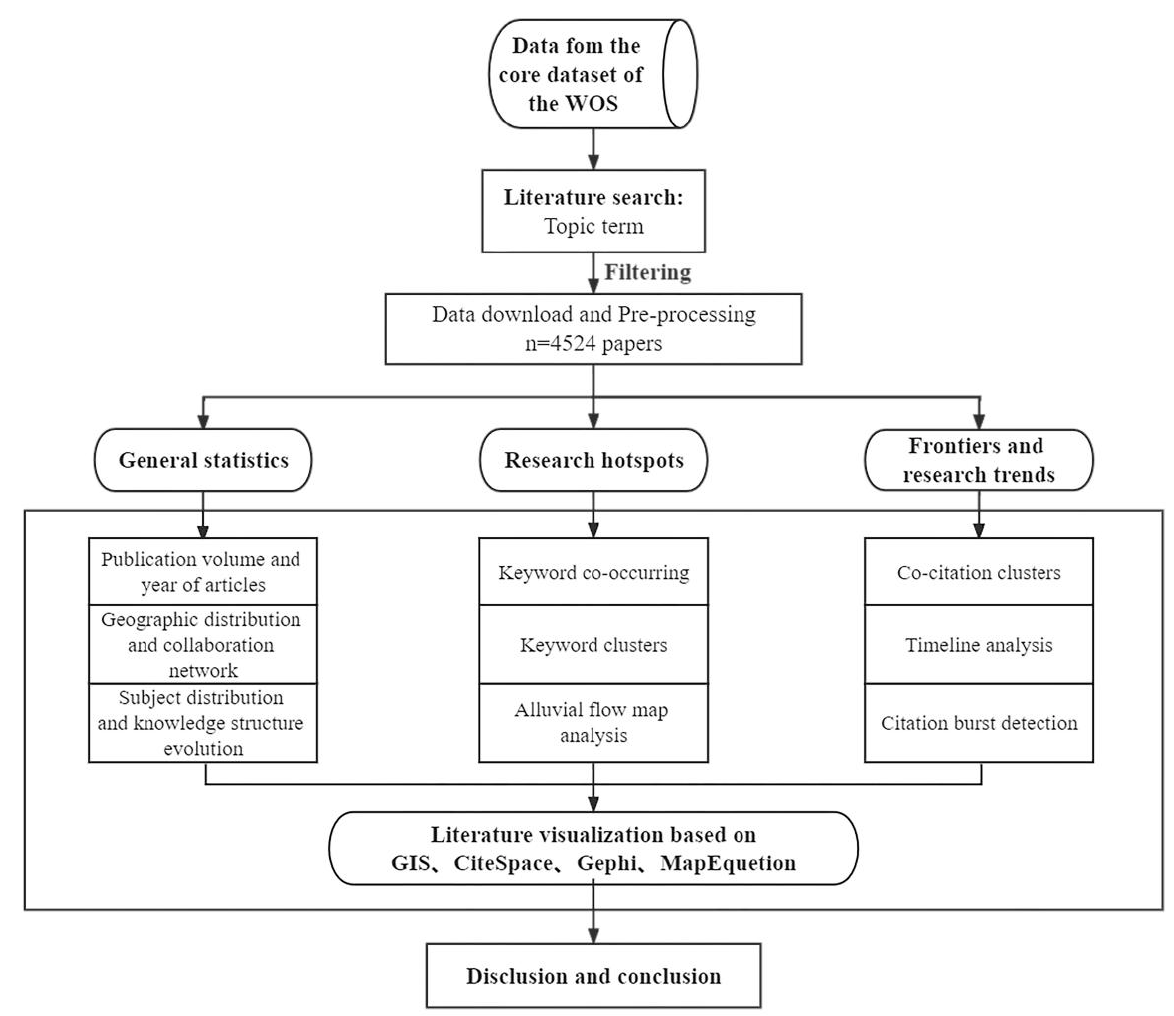
Figure 1. Flowchart of the research process.